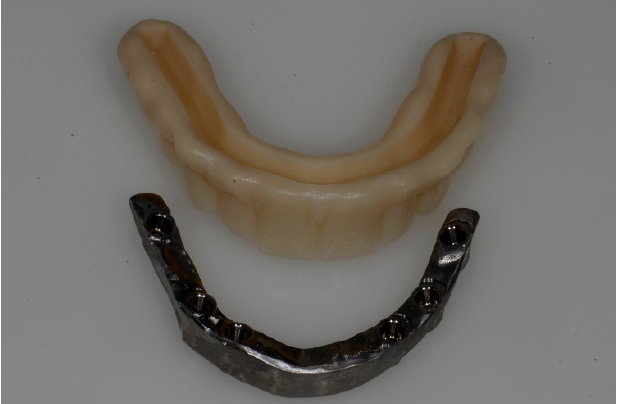
Figure 6. CAM output of the framework and of the suprastructure.